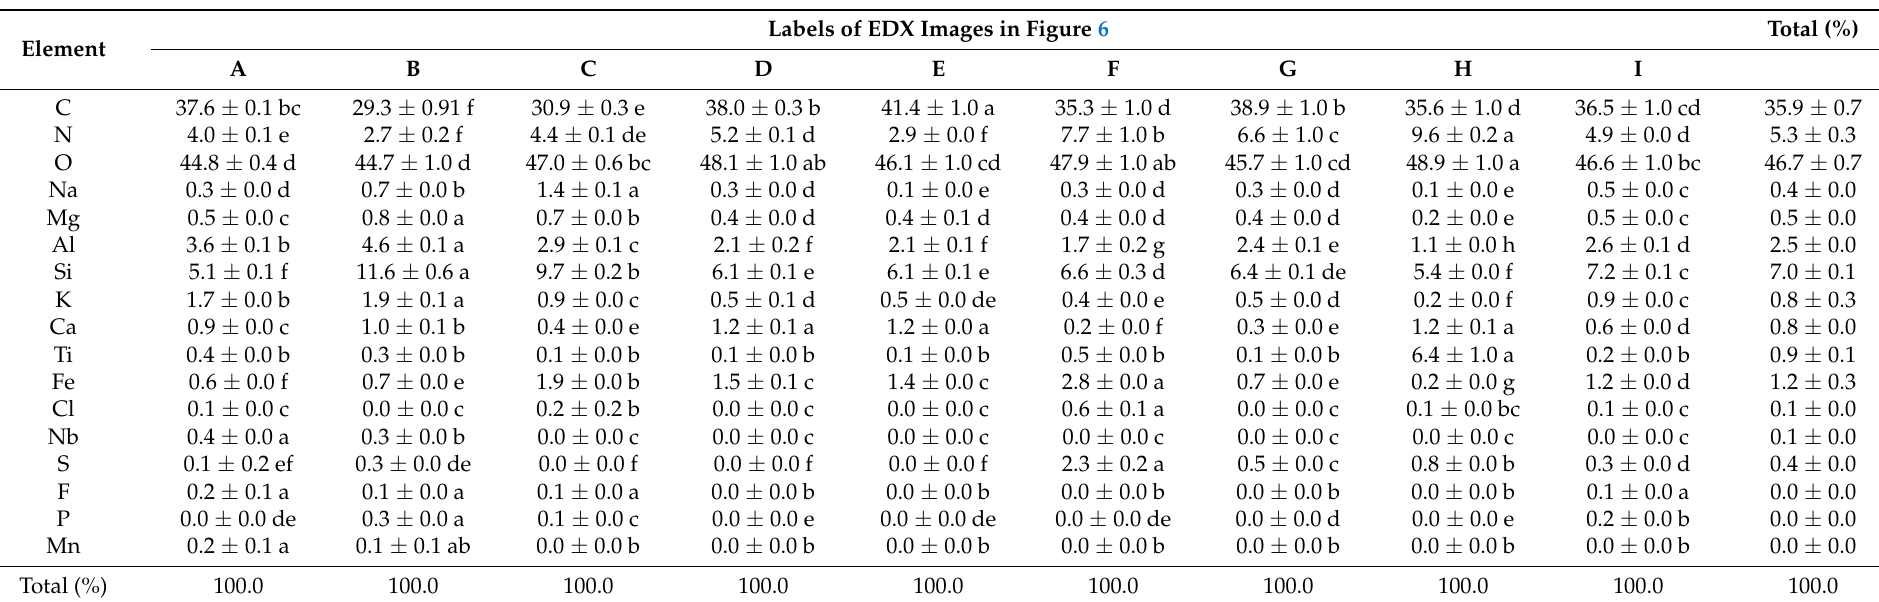
Table 6. Mean elemental composition (%, w / w ) of the three particles marked in red and blue in Figure 6. The analysis compared the elemental composition ratio of the morphology of particulate matter (A–I). Data are mean ± SD with 3 replicates of 30 leaves each. Species marked with different letters are significantly different by Duncan multiple test ( p < 0.05).